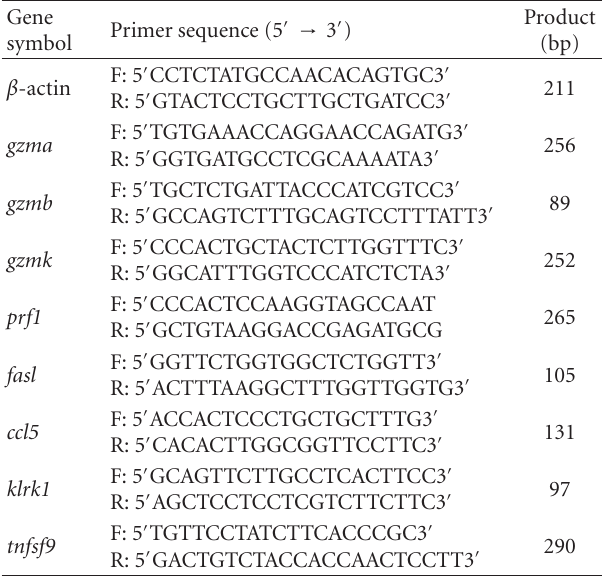
Table 1: qRT-PCR primers and